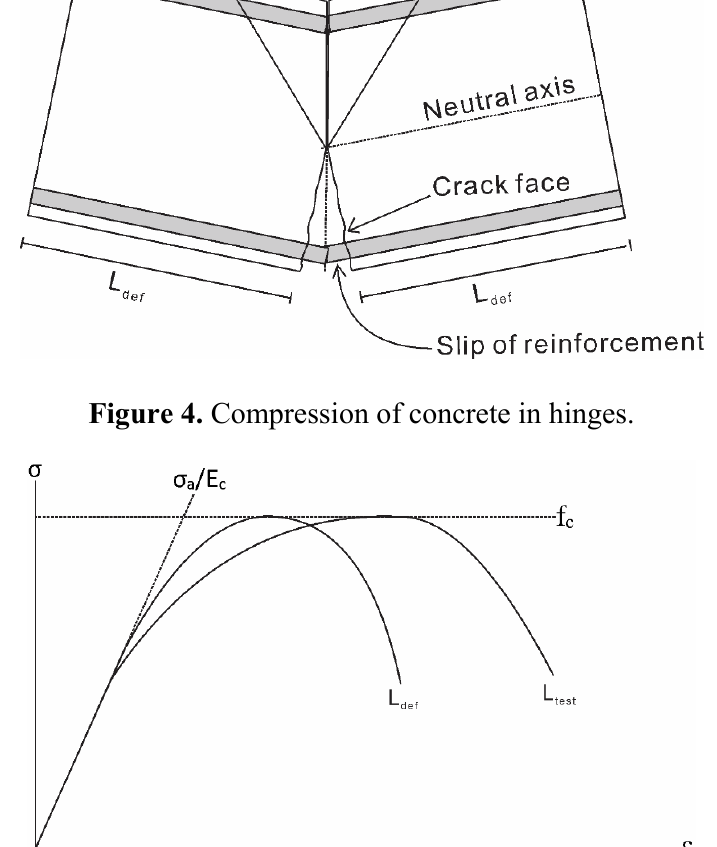
Figure 5. Empirical and size dependent stress-strain